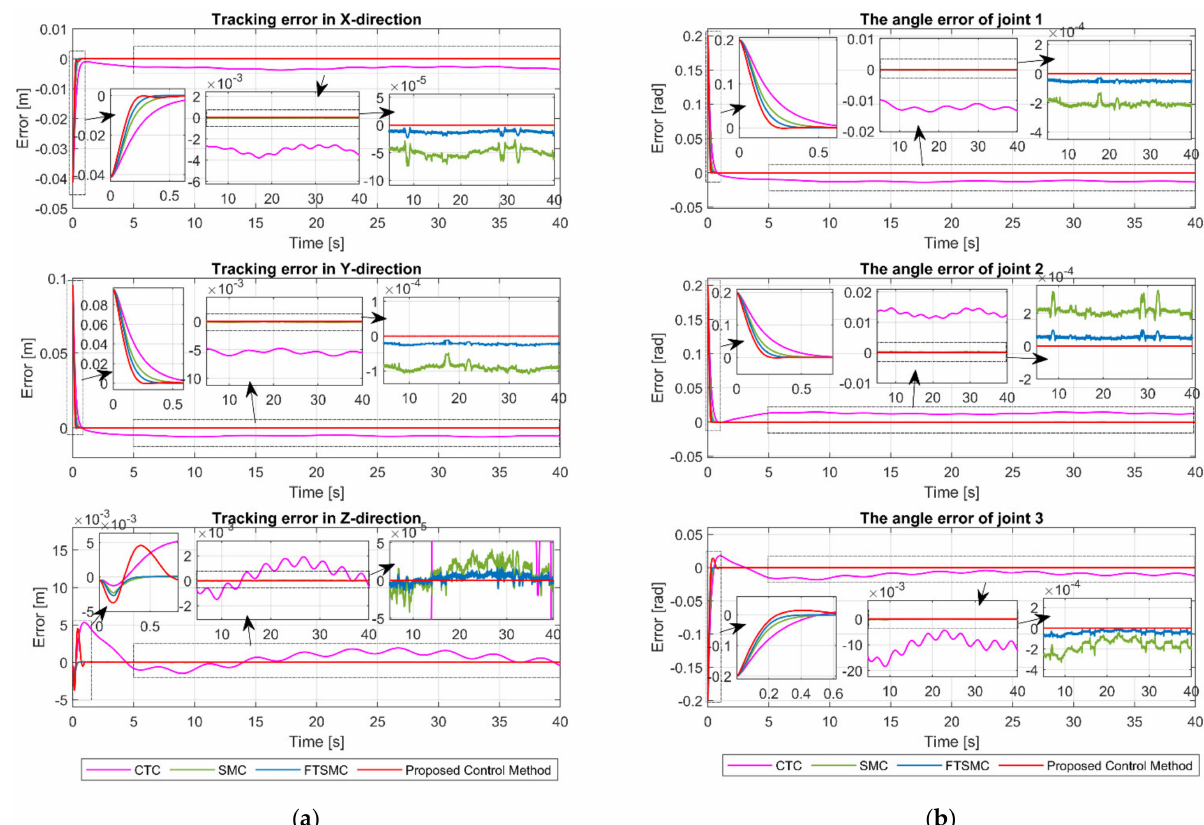
Figure 5. ( a ) The tracking errors of end-effector in X, Y, and Z direction; ( b ) the tracking errors of joint 1, joint 2, and joint 3.